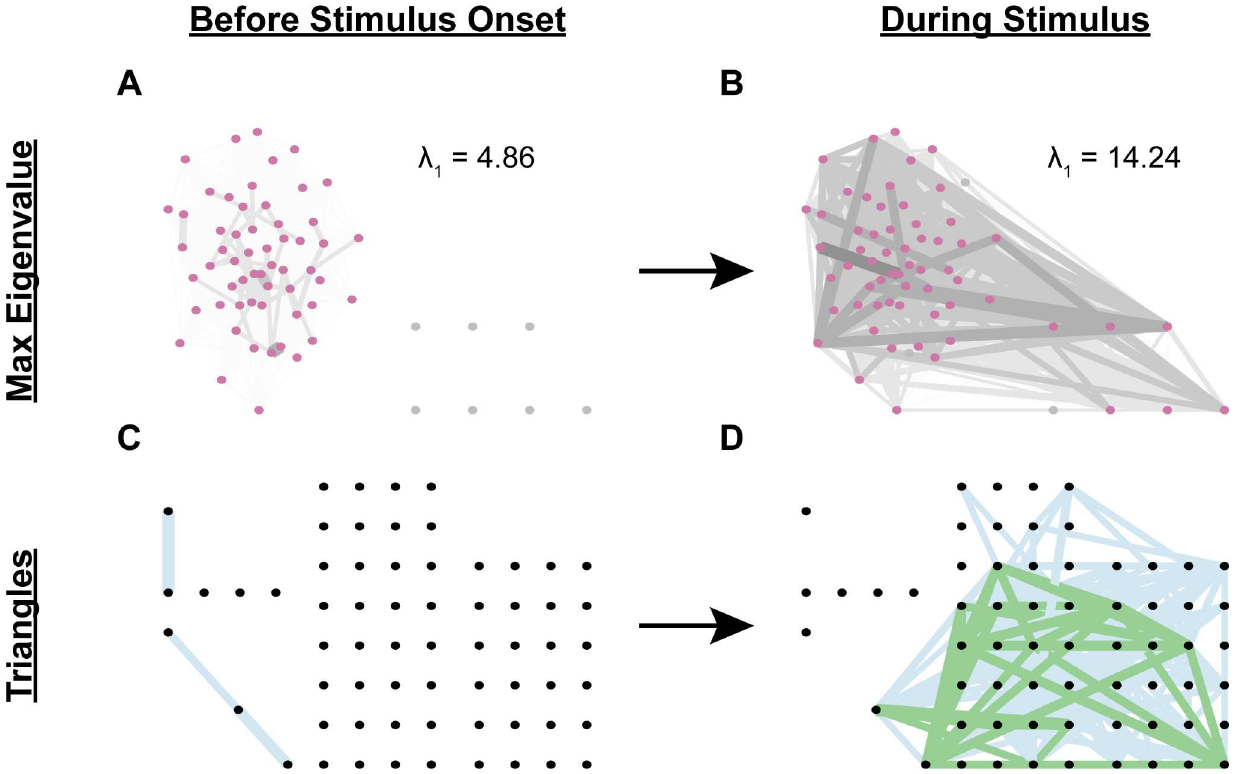
Fig 5. NaCl induces an increase in max eigenvalue and number of (strong) triangles. The networks depicted here, for one example worm, show neurons (circles) connected by lines (edges). In Panels A and B, the normalized mutual information (NMI) between any two neurons is indicated by both edge shading and thickness, where darker and thicker lines indicate larger NMI. Panels A and B show the network’s max eigenvalue ( λ 1), and Panels C and D depict the strongest (i.e., NMI > = 0.4) interactions in the network (hence, why many edges are missing), with those in green indicating the presence of a triangle (i.e., a triplet of connected neurons whose total weight > = 1.8) and those in blue its absence. Before the worm is exposed to 200mM NaCl, the neural network is composed of weak interactions, producing a low max eigenvalue (A), and no strong triangles (C). Once exposed to 200mM NaCl, the worm’s neural network has many stronger interactions, increasing its max eigenvalue (B), and forming several strong triangles (D). Edges in panels A and B were assigned to 0.2-wide bins from 0 to 1. All edges less than 0.4 were removed from panels C and D for the purpose of visualization. Neuron positions were fixed between panels A and B, and C and D, such that A can be directly compared to B, and C can be directly compared to D.